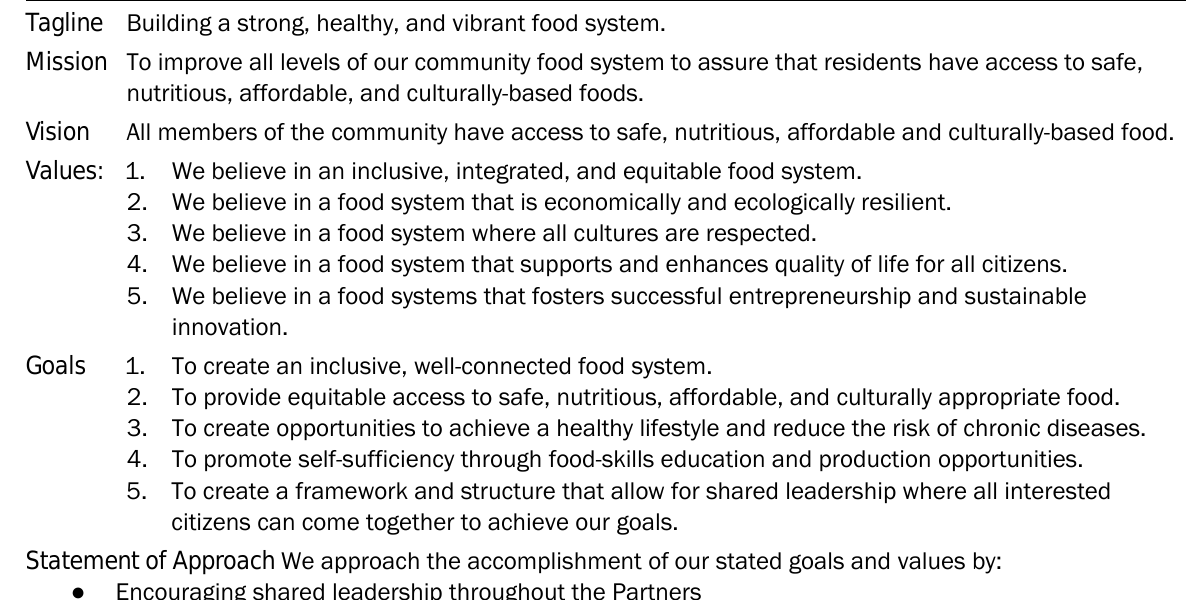
Figure 1. Strategic Communications Language for Cass Clay Food Partners Tagline Building a strong, healthy, and vibrant food